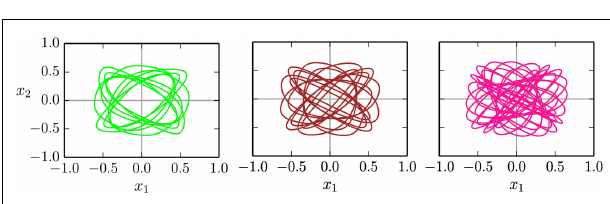
FIGURE 10 | Examples of higher order limit cycles found for the two-rod barrel, closing (within numerical accuracy, viz the thickness of the lines) after 9/13/21 revolutions around the origin ( x 1 , x 2 )=(0,0) (left/middle/right) . The gain is a = 1.9 and the respective adaption rates are ε = 0.92, 0.76, and 0.61, compare Figure 8